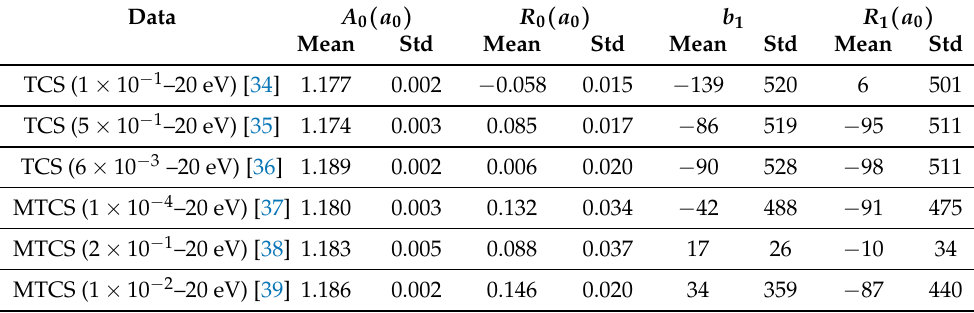
Table 1. Mean values and standard deviations of MERT parameters (appearing in the effective range approximation, Equation (10)) for e − + He elastic scattering. The results were calculated using the dipole polarizability α = 1.407 a 3 [40] and the effective quadrupole polarizability β = 0.0 a 5 0